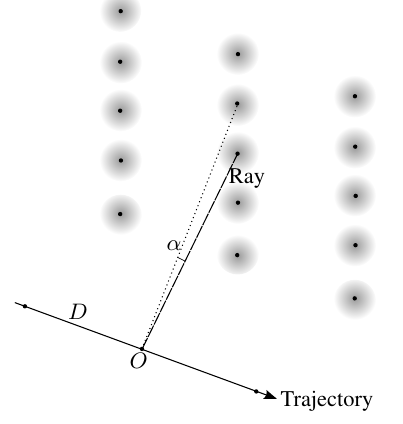
Figure 1: Laser scanning geometry